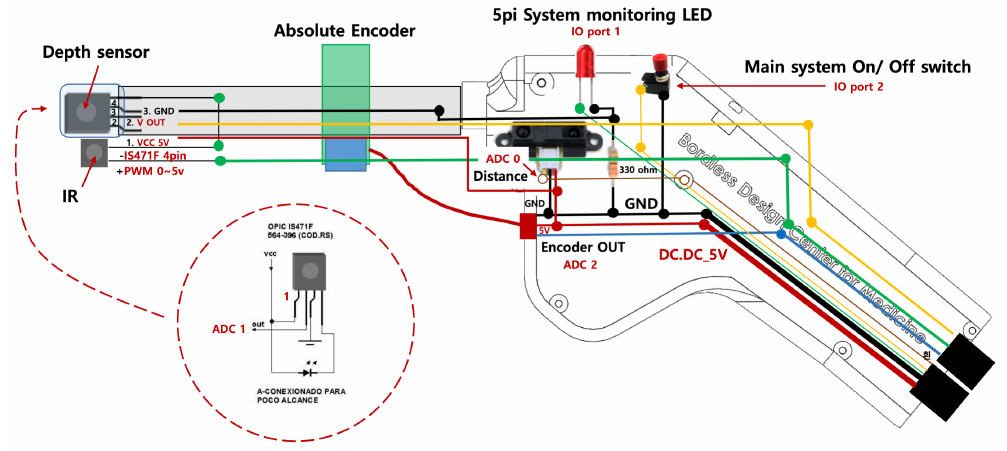
Figure 4. Schematic of the electrical diagram of the balloon-type vaginal